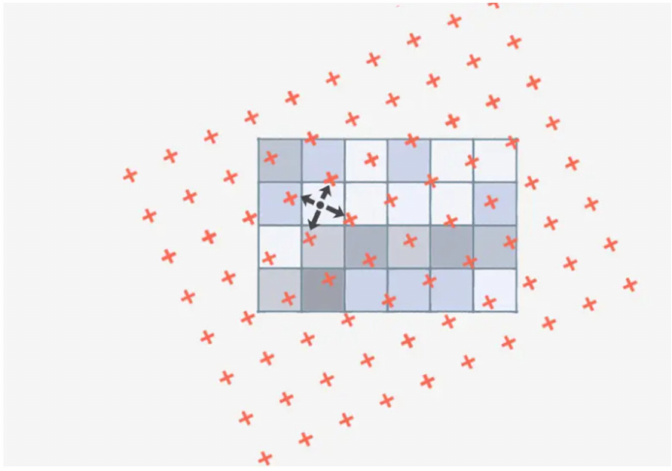
Figure 7. Resampled image cell size with 4 nearest neighbours (Reprinted with permission from Ref.